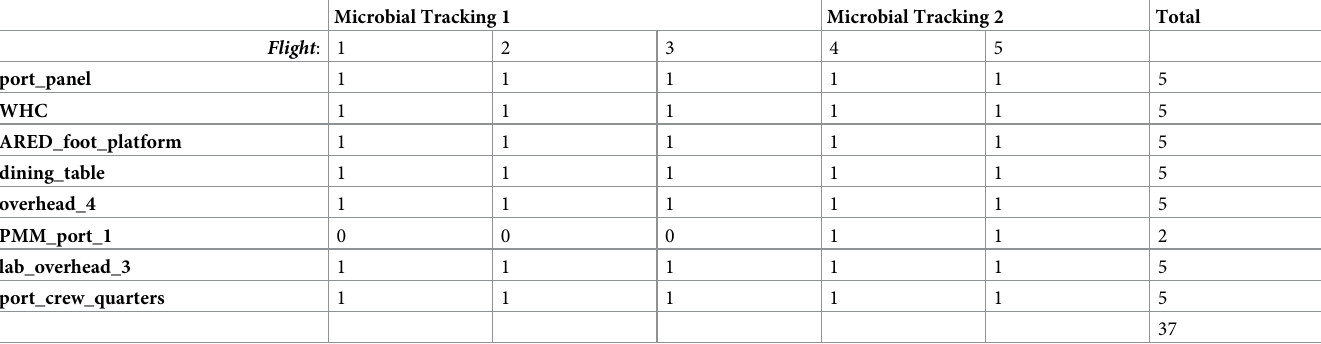
Table 2. Number of surface samples per location per